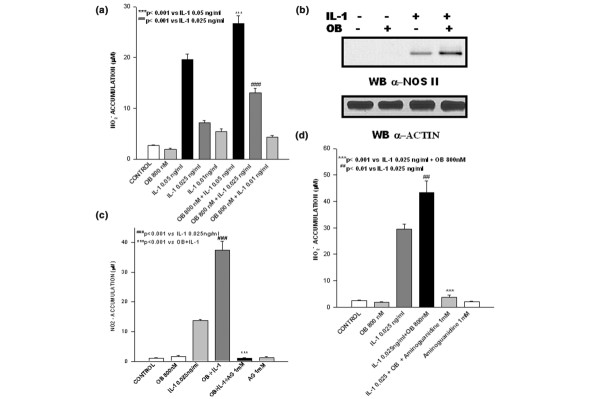
Leptin synergizes with IL-1 in inducing nitric oxide synthase (NOS) type II. Synergistic effect of leptin (OB) on nitrite (NO2-) accumulation and NOS type II protein expression induced by IL-1. Stimulations were conducted in serum-free conditions (a,b) in ATDC5 chondrogenic cells and (c) in human primary chondrocytes. NO2- accumulation is selectively inhibited by aminoguanidine (AG) both in (d) ATDC5 cells and in (panel c) human primary chondrocytes. Values are expressed as mean ± standard error of the mean. WB, western blot.